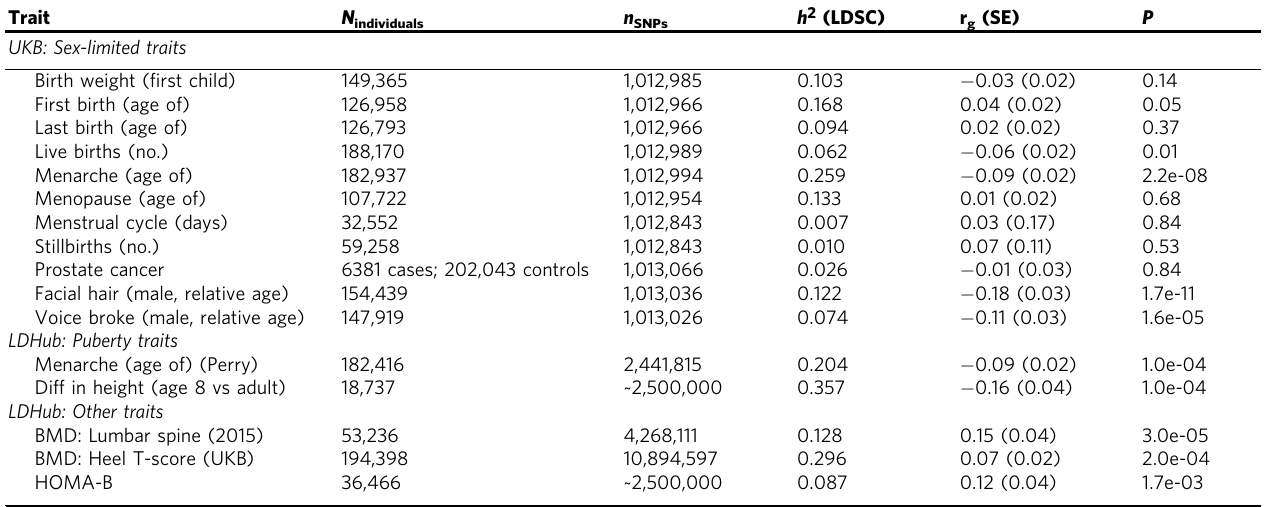
(Table 1, Supplementary Data 8). LDHub reproduced r g that we had identi fi ed in UKB GWAS, with ages at facial hair onset ( r g = − 0.23, SE = 0.04, P = 2.2e-8), voice breaking ( r 0.04, P = 6.0e-4) and menarche ( r g = − 0.09, SE = 0.02, P =